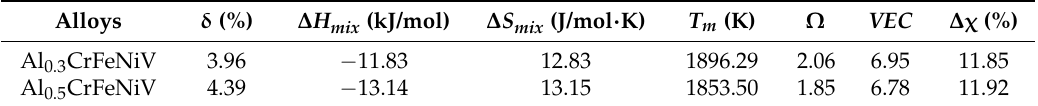
Table 3. Parameters of δ , ∆ H mix , ∆ S mix , T m , Ω , VEC , and ∆ χ of the Al x CrFeNiV ( x = 0.3, and 0.5)